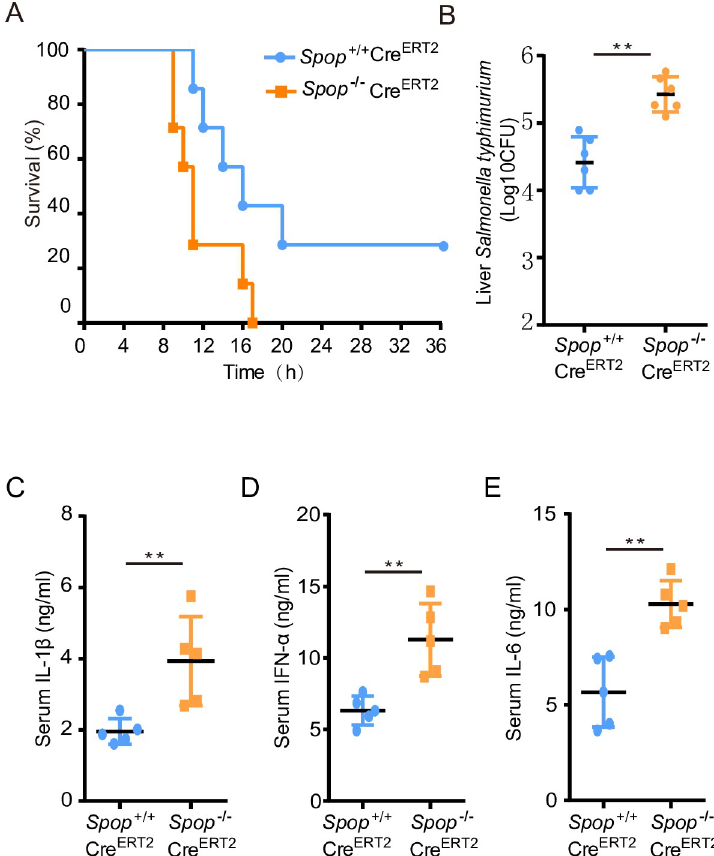
Fig 5. SPOP deficiency attenuates resistance against Salmonella infection in mice. Spop F/F CreERT2 +/+ knockout mice were generated by Cre-LoxP recombination. Conditional knockout mice were intraperitoneally injected with tamoxifen three times every other day at a dose of 175mg/kg body weight. (A) Mice were challenged with Salmonella typhimurium and their survival rates monitored for 36 hours (n = 7 each group; statistical analysis: Mantel–Cox test). (B) Bacterial load in the livers of Spop -/- Cre ERT2 and Spop +/+ Cre ERT2 mice injected intraperitoneally with Salmonella typhimurium . (C), (D), and (E) ELISA for IL-1 β , IFN- α and IL-6 in the serum from Spop +/+ Cre ERT2 and Spop -/- Cre ERT2 mice challenged with Salmonella typhymurium for 6 h (n = 5 per genotype). �� p < 0.01 and error bars reflect ± SD.